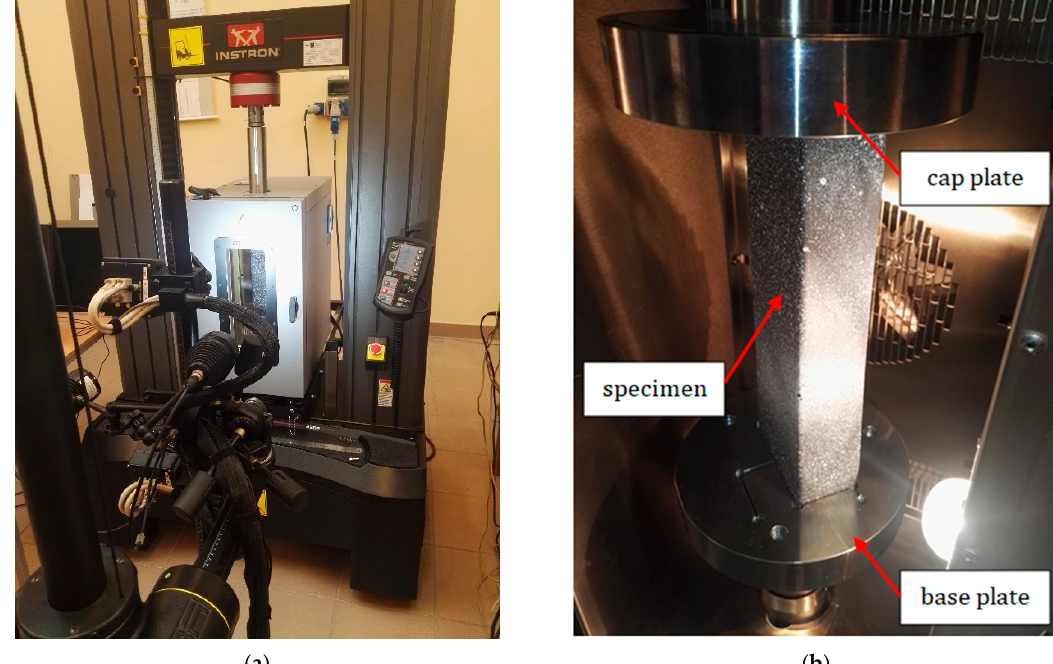
Figure 2. The stand with Aramis system ( a ) and the column in the chamber before the test ( b ).